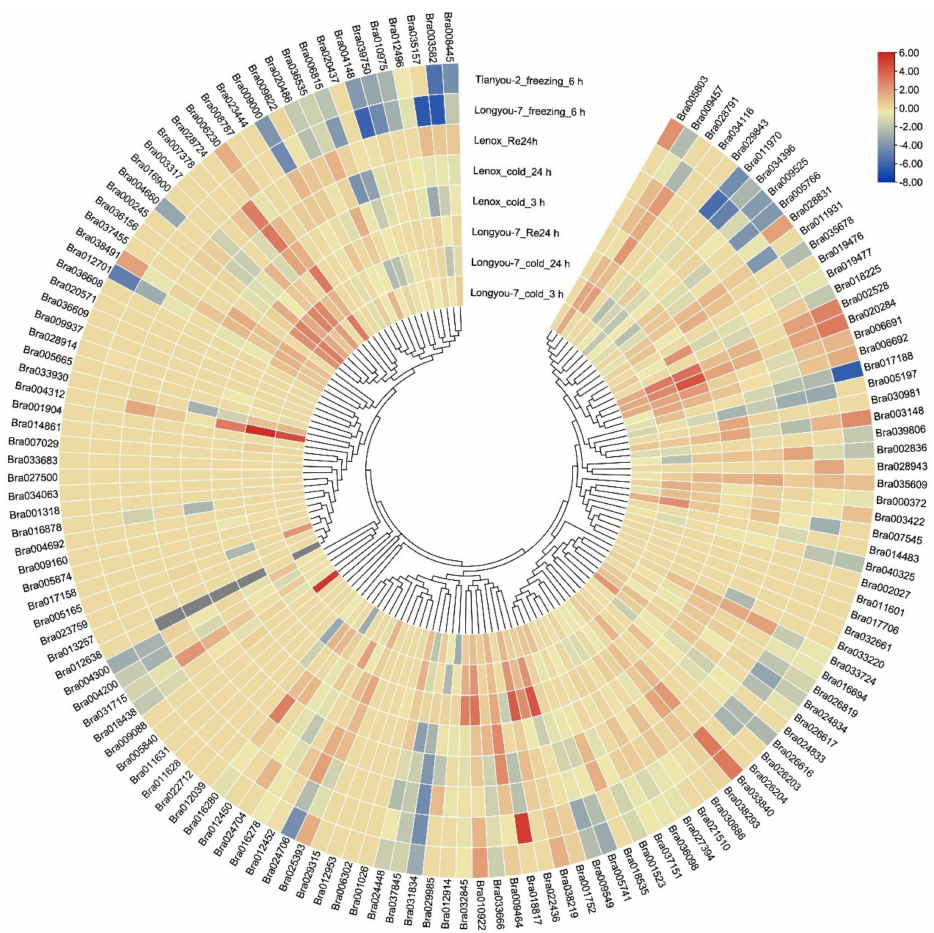
Figure 5. Expression of C2H2 ZFP genes in different varieties under cold and freezing stress. Heat maps were expressed using log2 values for each gene. The color scale represents the relative expres- sion levels from low (blue) to high